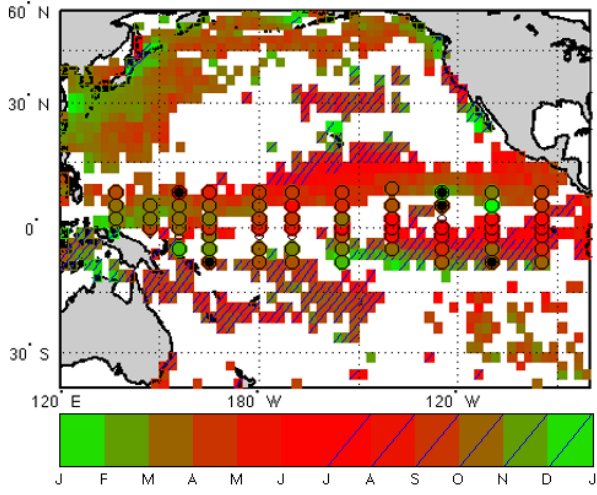
Fig. 4. As in Fig. 3, but for the phase. Color scale is shown at bottom with units of months, indicating the month of maximum SLS. Light blue slashes mean maximum SLS occurred during the second half of the year. For TAO/TRITON moorings a dark black dot in the middle indicates maximum SLS in the second half of the year.